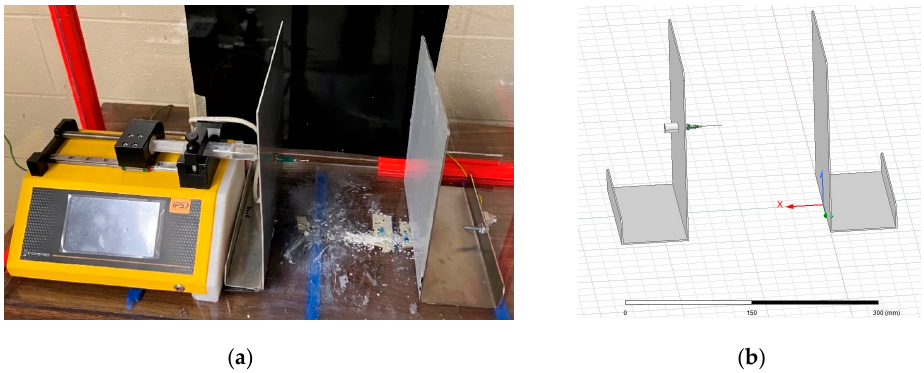
Figure 2. ( a ) Physical electrospinner needle–plate setup; ( b ) ANSYS simulation electrospinner needle–plate setup.